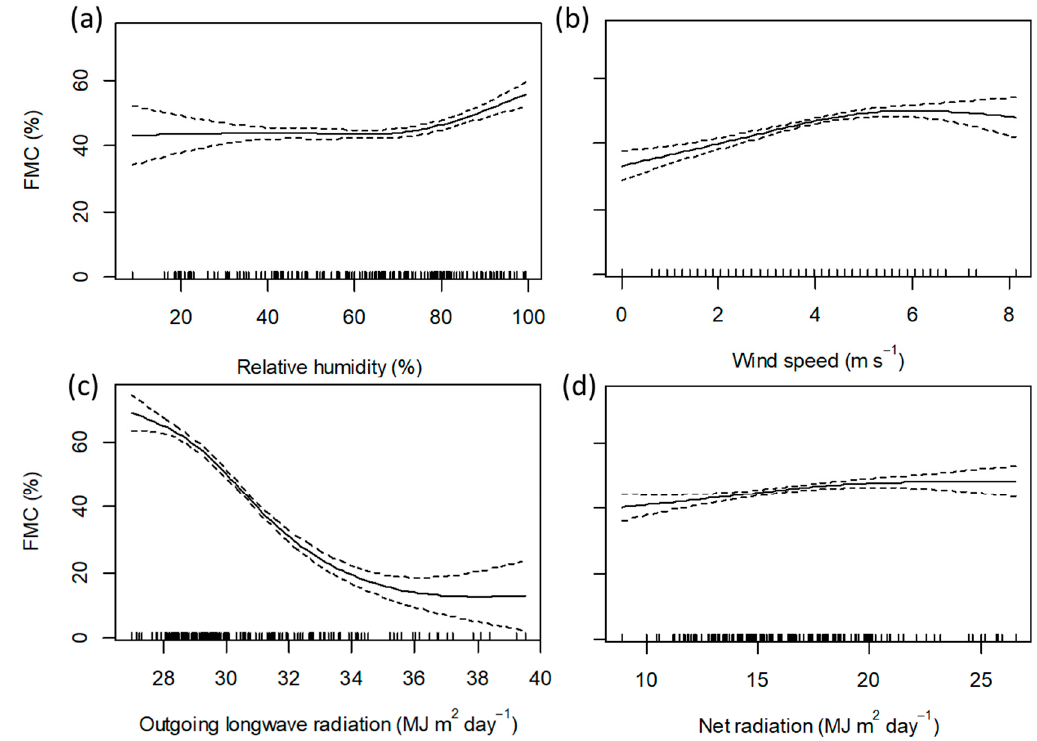
Figure 6. Partial plots of GAMM INDP fits for mean daily FMC (%): ( a ) relative humidity, ( b ) maximum wind speed, (c) outgoing longwave radiation and ( d ) net radiation. The plots are centered on mean FMC with 95% confidence intervals.